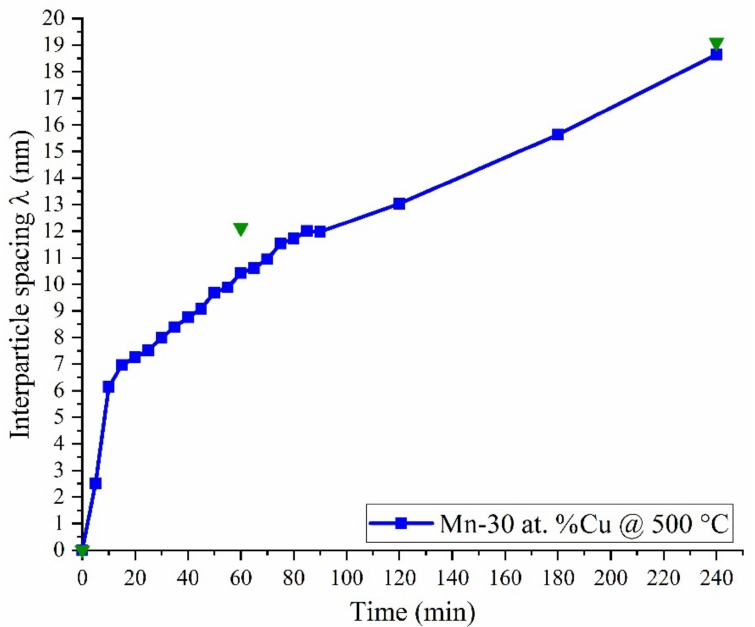
Figure 10. Plot of interparticle spacing λ in γ (cid:48) phase versus time for the Mn-30 at. %Cu alloy aged at 500 ◦ C. The green marks represent the experimental results of Vitek and Warlimont